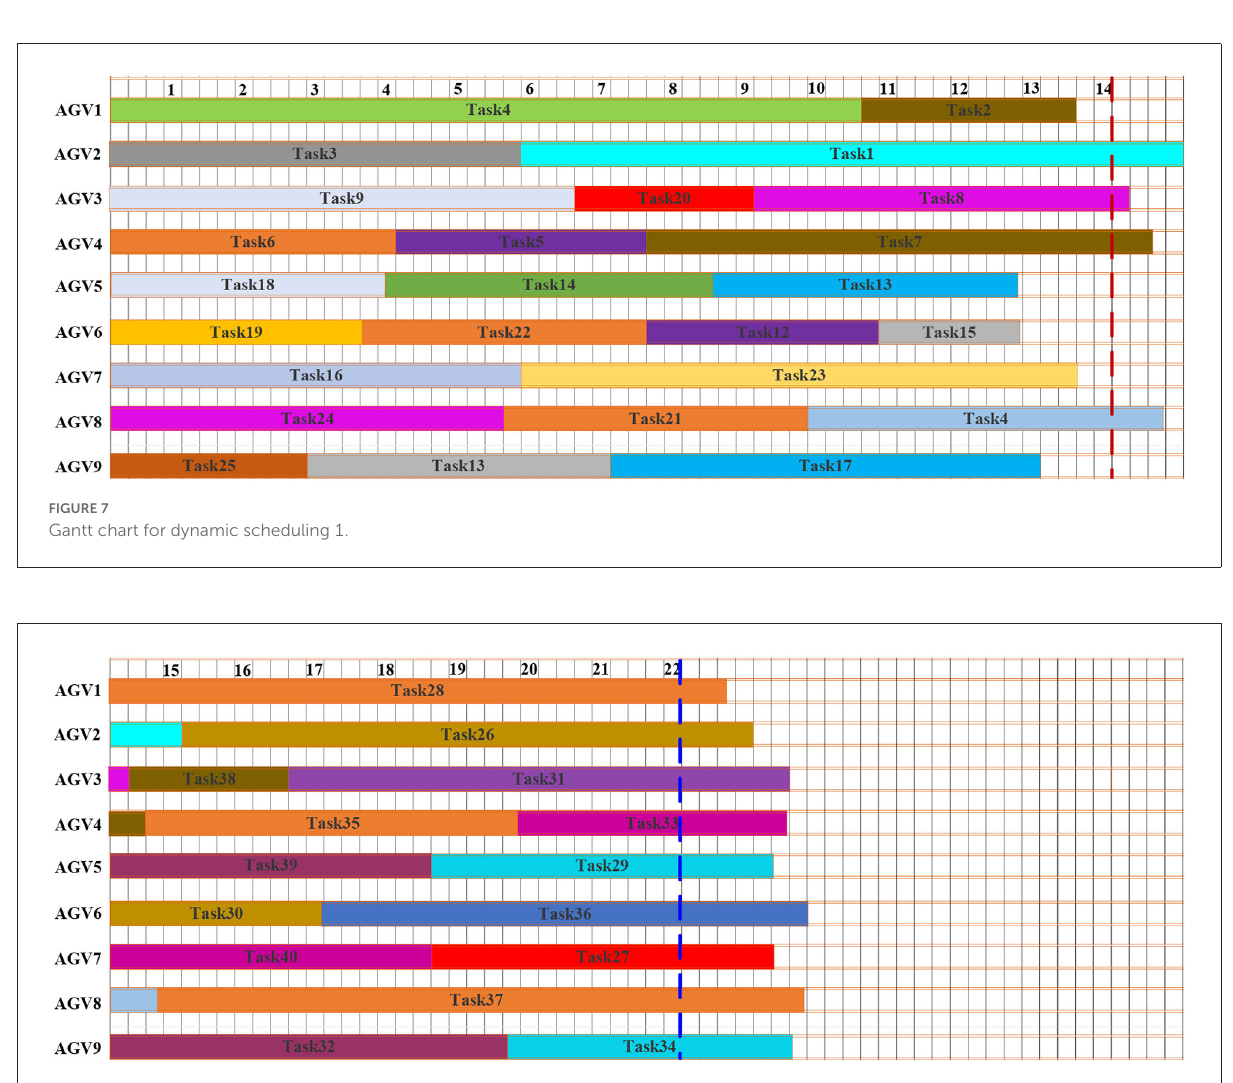
FIGURE8 Gantt chart for dynamic scheduling